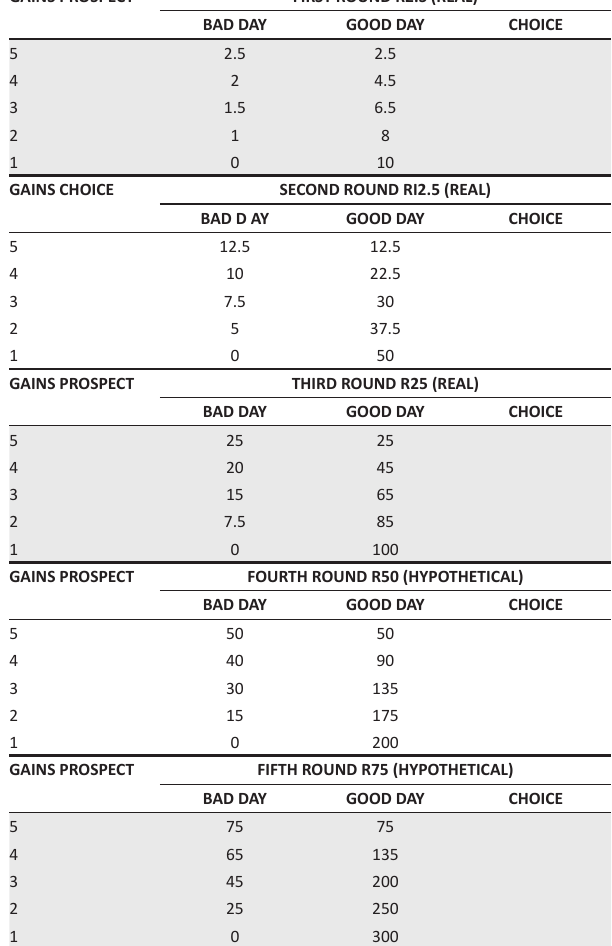
TABLE 1-A1: (Gains only) lottery games used in the experiment (amounts in